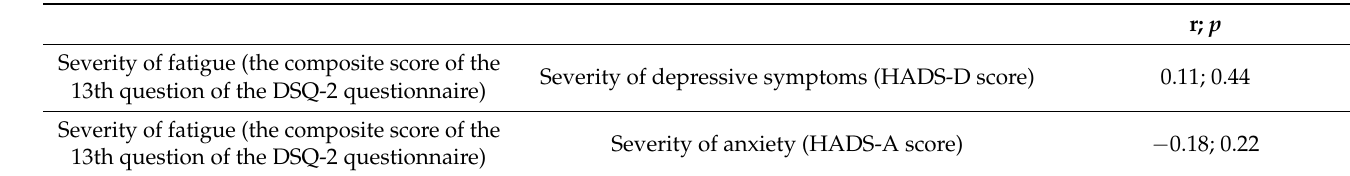
Table 6. Results of the correlation analysis between the severity of the depressive or anxiety symptoms and the severity of